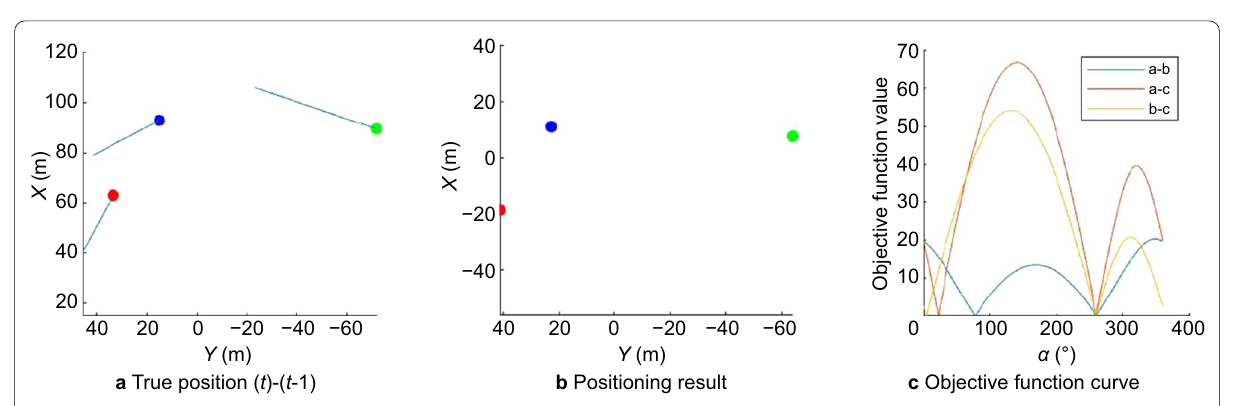
Fig. 11 Circular formation scenario, simulation result at time t =